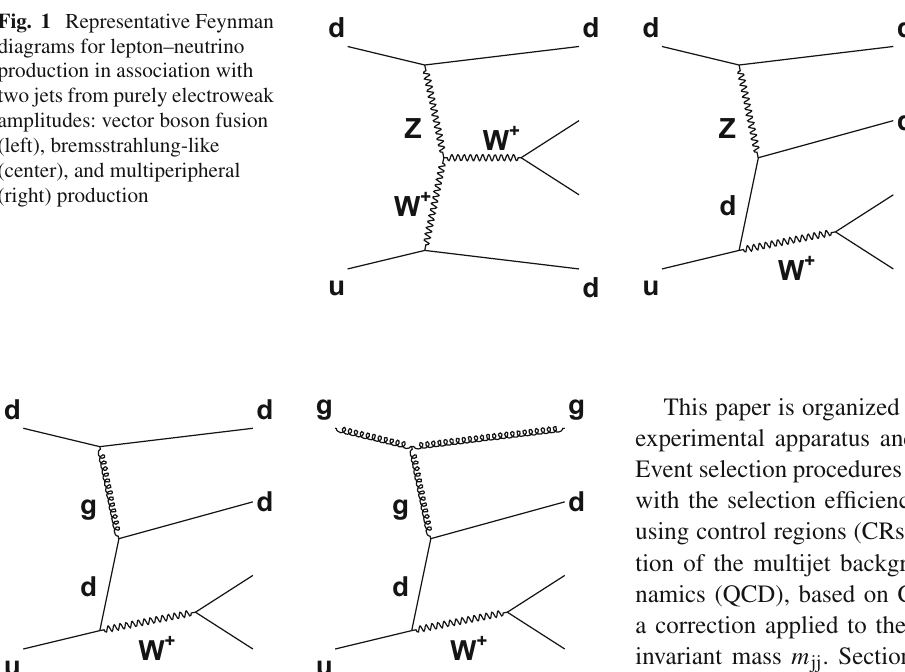
Fig. 2 Representative diagrams for W boson production in association with two jets (DY Wjj) that constitute the main background for the